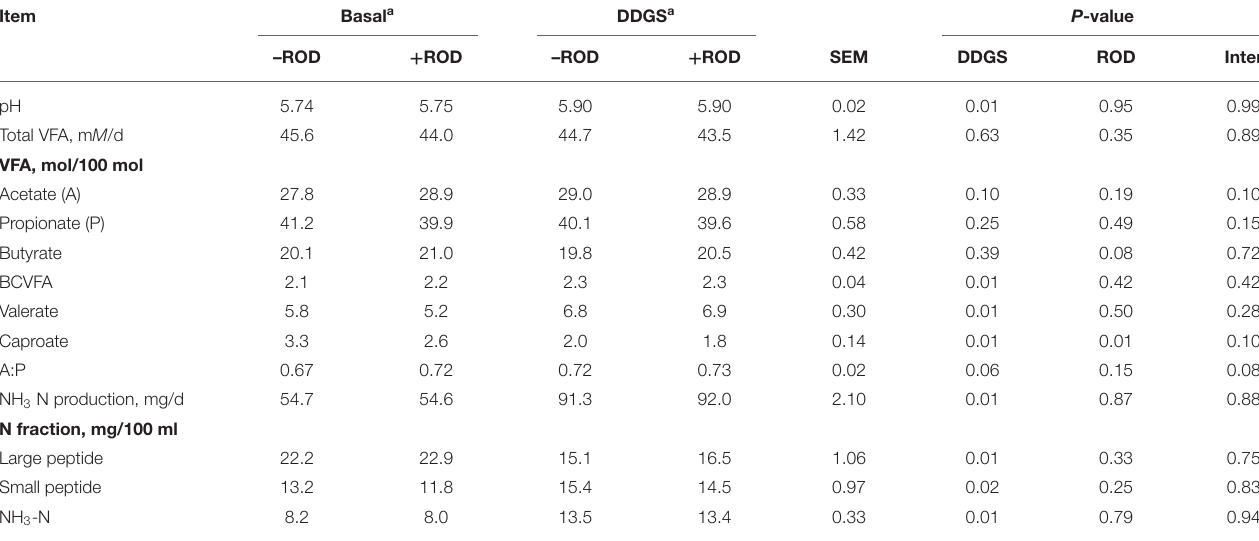
TABLE 2 | Effect of wheat dried distillers grains with solubles (DDGS) and the red osier dogwood (ROD) extract on fermentation and nitrogen fraction in RUSITEC. Item Basal a DDGS a P -value –ROD + ROD –ROD + ROD SEM DDGS